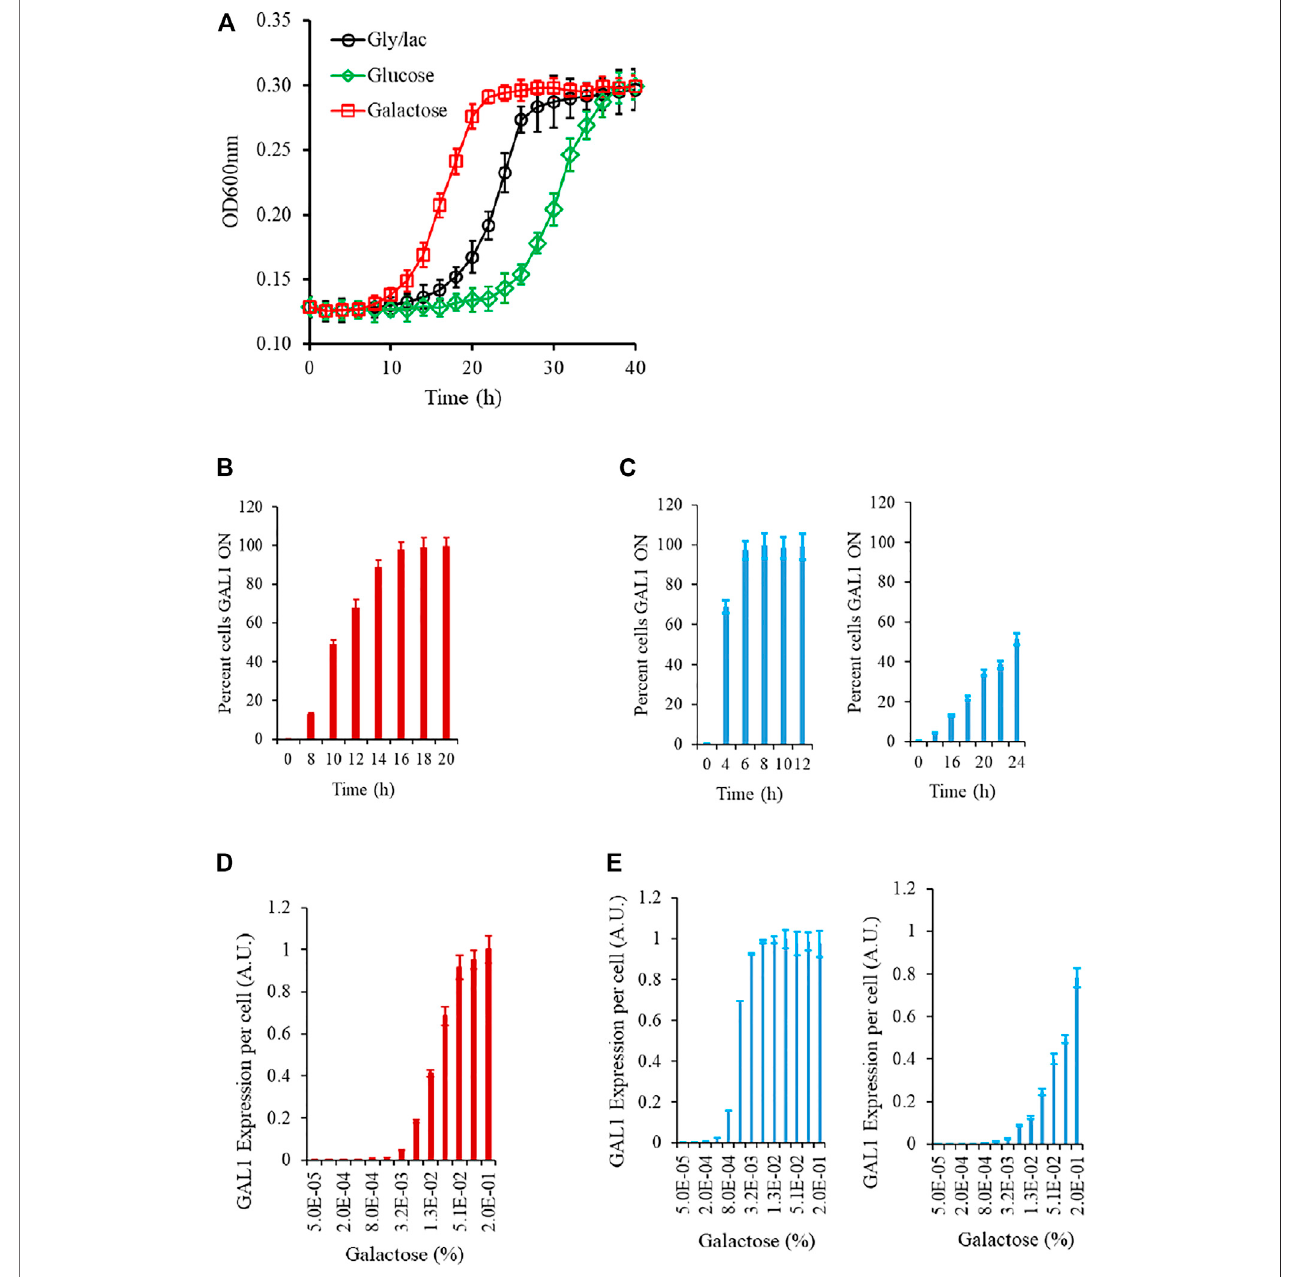
FIGURE 2 | Experimental characteristics of the GAL network in S. cerevisiae. (A) Growth kinetics in galactose is contingent on the conditions in which the cells are introduced from. The lag is the longest in the cells introduced from glucose, and shortest in those introduced from galactose. (B) During transition from gly/lac to galactose, the percent cells which are expressing GAL1 is heterogeneous in the initial phase of the growth. (C) Same as (B) . The transition from lag to log phase in the epistatically-altered strain (left) and the gal3 Δ strain (right) is qualitatively different. (D) Steady state GAL1 expression in ancestral strain, when cells are grown in different galactose concentrations. (E) Sameas (C) but for the epistatically-altered strain (left) and the gal3 Δ strain (right). The nature of galactose gene expression in the three strains is qualitatively different from each other. All experiments were performed in triplicate. The average and standard deviations are reported.